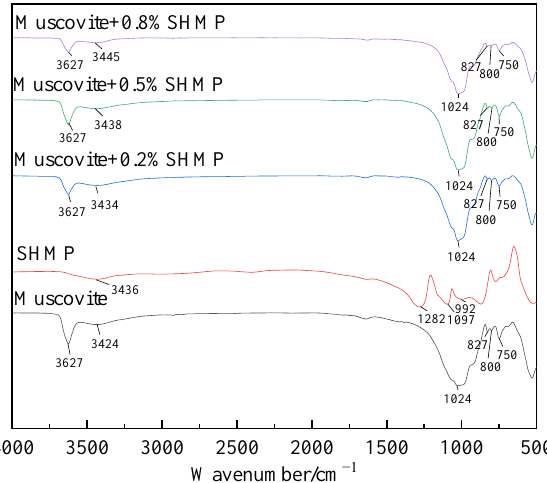
Figure 6. Infrared spectra of different samples. In Figure 6, the absorption peaks of muscovite at 3627 cm − 1 and 3424 cm − 1 are